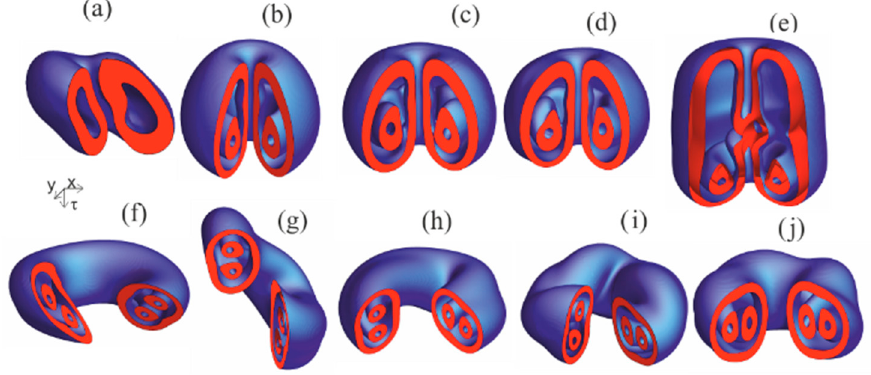
Figure 12. Domains of electromagnetic energy sources (red) and sinks (blue) for solitons shown in Figure 11 with the same labels.